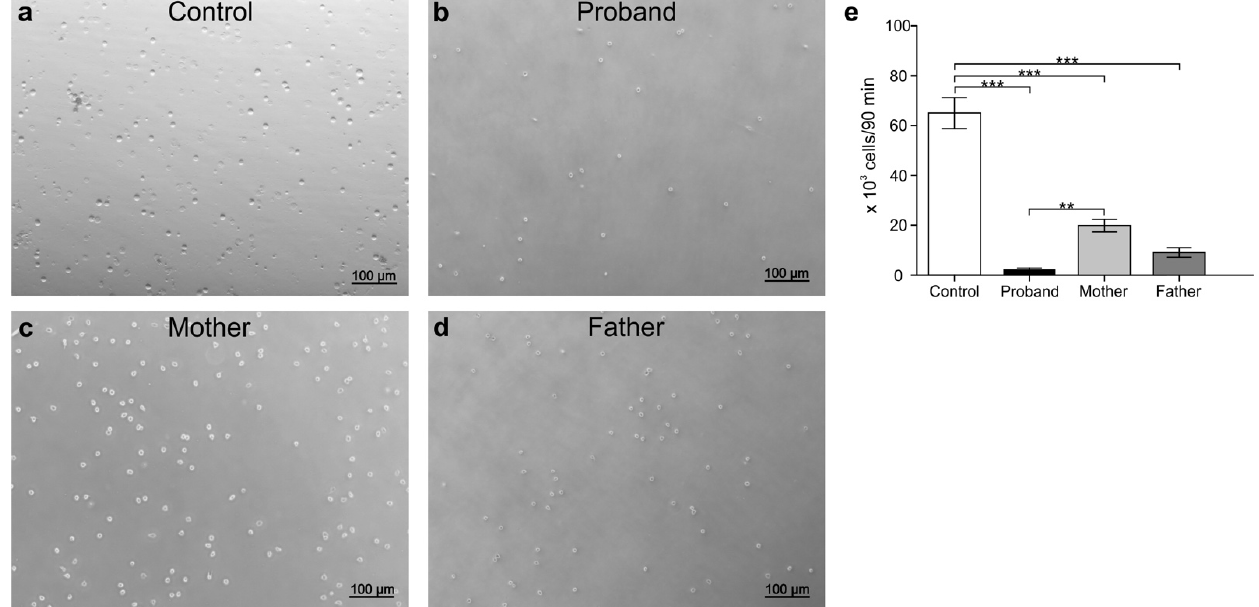
Figure 6. Transmigration of polymorphonuclear cells assays. Peripheral blood polymorphonuclear cells (PMNCs) were isolated from different subjects: control ( a ), proband ( b ), mother ( c ), and father ( d ). Subsequently, the cells (120,000) were added to the surface of a transwell filter (Ø = 3 µm) and stimulated with 1 µM of the chemoattractant fMLP. Afterwards, the cells were incubated at 37 °C for 90 min, the transmigrated cells subsequently counted, and the results compared using t -test ( e ). ** p < 0.01, *** p < 0.001. n = 3. Data are represented as the mean ± SD.